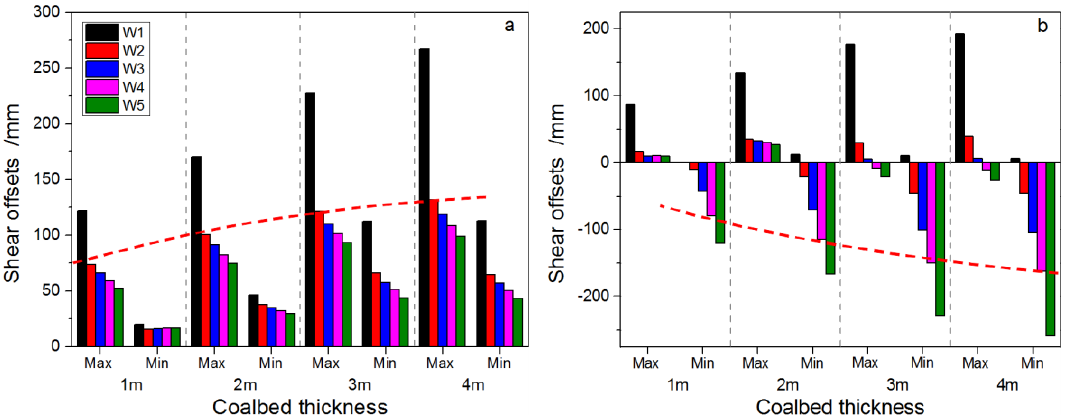
Figure 5. Extreme value statistics of lateral shear offsets of hydrocarbon wells after the ( a ) first panel is removed and then ( b ) the second panel is removed for various SMHs.